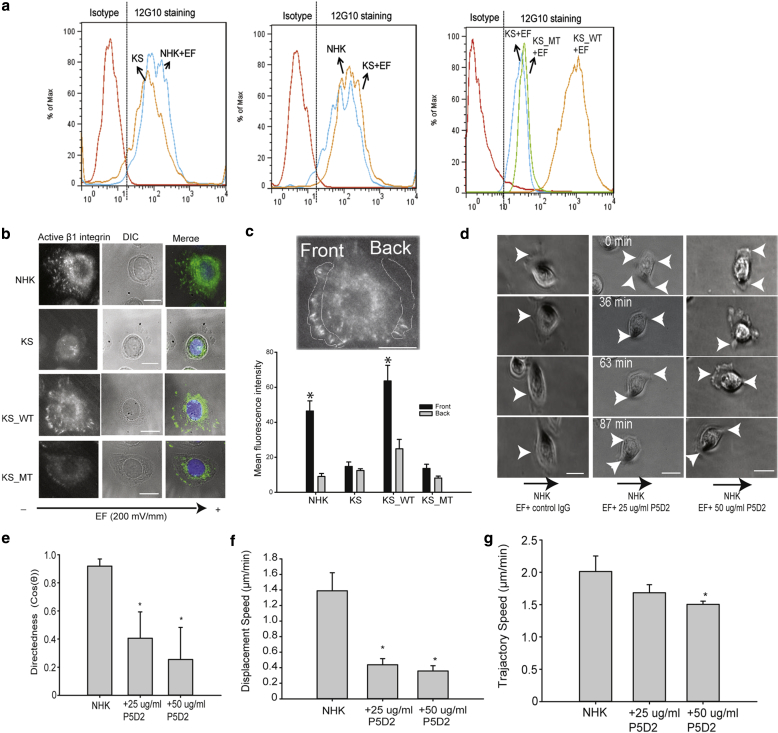
Kindlin-1–mediated β1 integrin activation is required for keratinocyte electrotaxis. (a) FACS shows an increase of peak fluorescent of active β1 integrin in (left) EF-treated NHK but not (middle) EF-treated KS; EF-treated KS_WT showed a much stronger fluorescent signal than (right) EF-treated KS and KS_WT cells. (b) Representative confocal images of active β1 integrin in NHK, KS, KS_WT, and KS_MT after EF. (c) Example image showing regions used for intensity analysis. Graph shows mean intensity values of active β1 integrin in the front versus rear of migrating cells. (d) NHK cells treated with indicated β1 integrin inhibition antibody P5D2 during EF (see Supplementary Video S5). Arrowhead indicates pseudopod. EF is horizontal, with cathode to the left. (e) Migration directedness, (f) displacement speed, and (g) trajectory speed of NHK with indicated β1 integrin inhibition antibody. Results are presented as means ± standard error of the mean, n ≥ 6. ∗P < 0.05. Scale bar = 50 μm. EF, electric field; KS, Kindler syndrome; KS_MT, kindlin-1–mCherryW612A point mutation; KS_WT, Kindler syndrome cells infected with wild-type kindlin-1–mCherry; Max, maximum; min, minutes NHK, normal human keratinocyte.